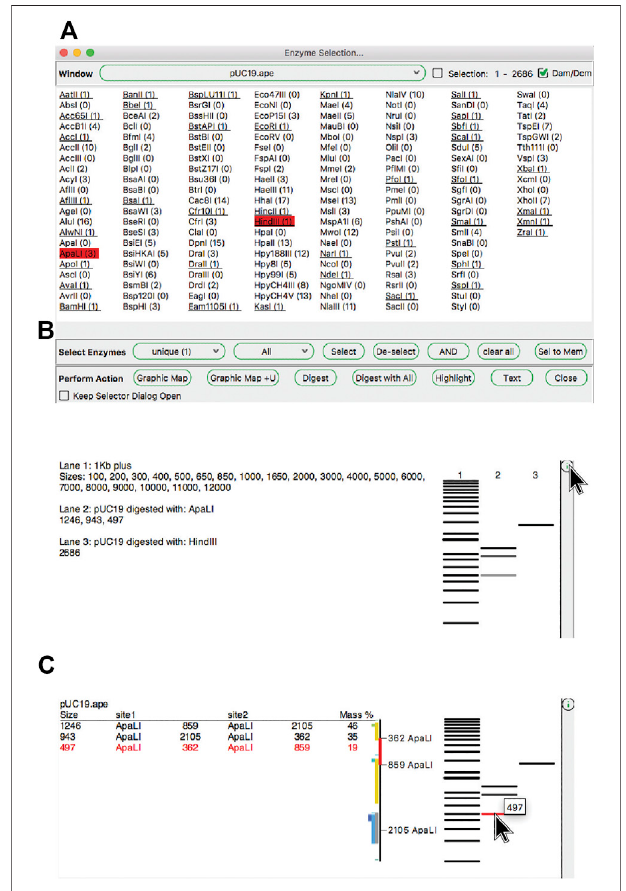
FIGURE3| Theenzymeselectordialogandvirtualagarosegels. (A) The enzyme selector dialog. (B) A simulated agarose gel of pUC19 digested with ApaLI and HindIII. The bands from each lane are shown in a table. (C) The same gel window, but showing detailed information for a single ApaLI band highlighted by hovering the mouse over the